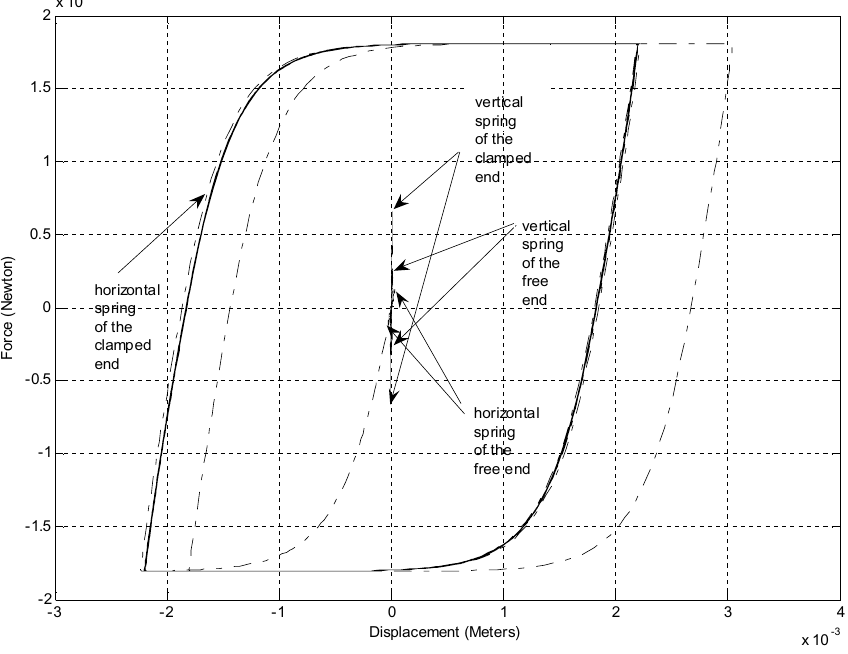
Fig. 8. Force-displacement diagrams of the hysteretic springs.